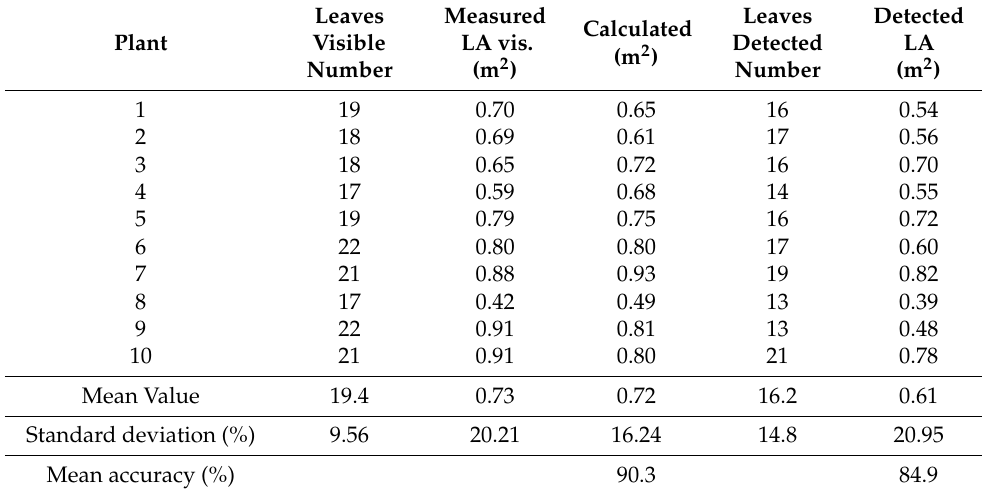
Table 5. BBCH 45: comparison of measured, calculated (calc.), and detected leaf area and the mean accuracy (MA) of the visible leaves